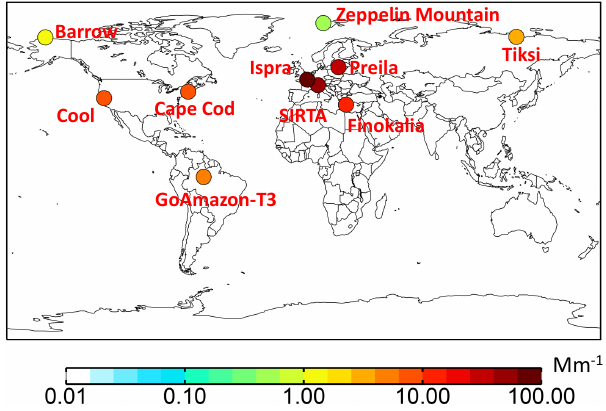
Figure 7. The locations of a series of field sites used in this study where multiple-wavelength absorption was measured using an Aethalometer. Each site is colored according to the mean aerosol absorption measured at 370nm. Values from the GoAmazon-T3 site are corrected, while others are uncorrected (see Sect.